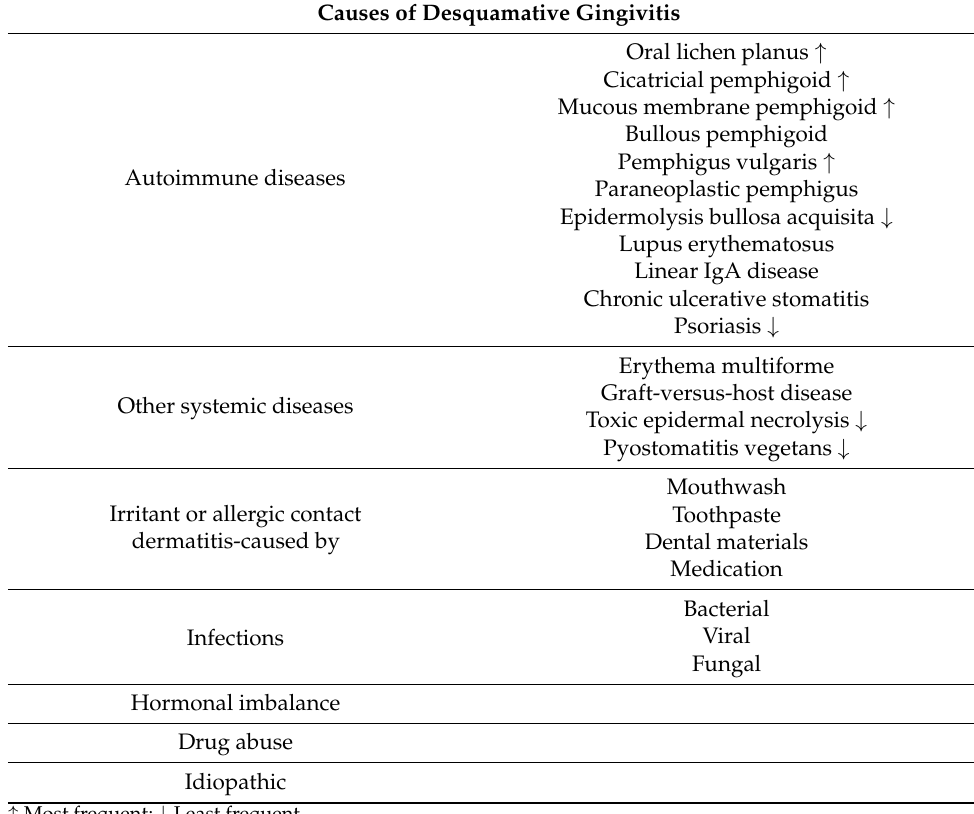
Table 1. Possible causes of desquamative